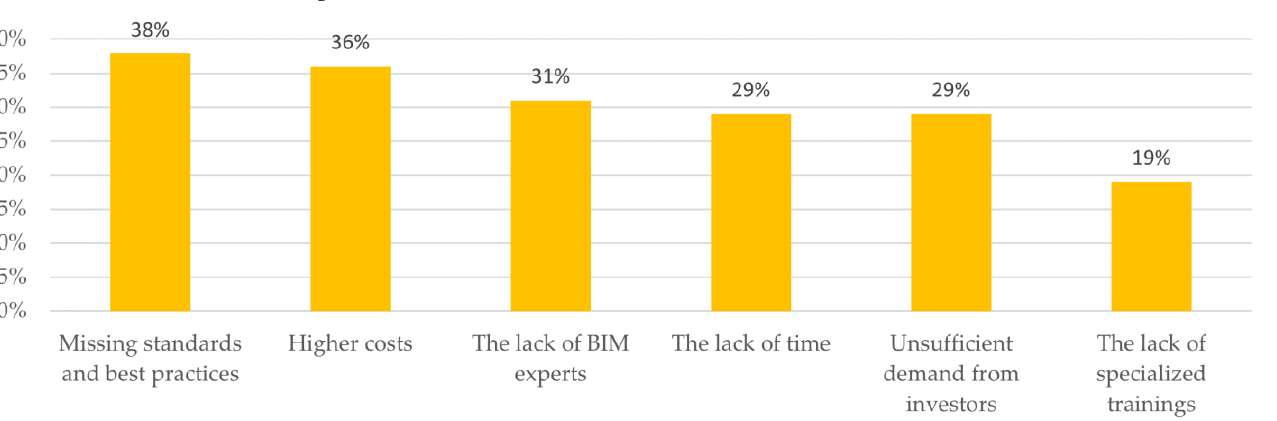
Figure 1. Main barriers to BIM usage in projects (note: respondents can identify more than one barrier) adapted from [10]. ref.